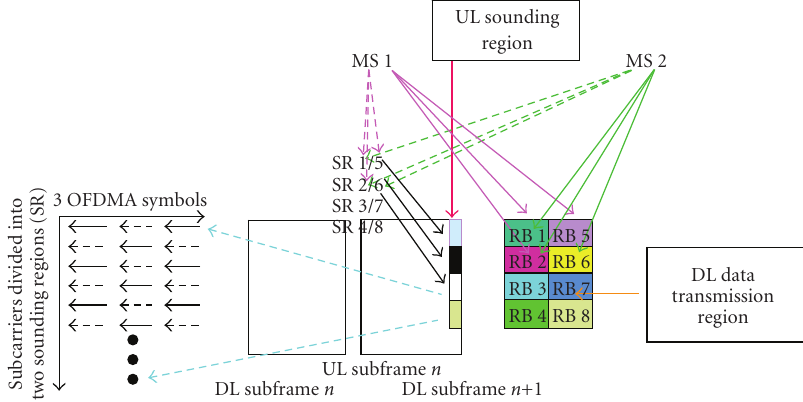
Figure 5: Special UL sounding design.